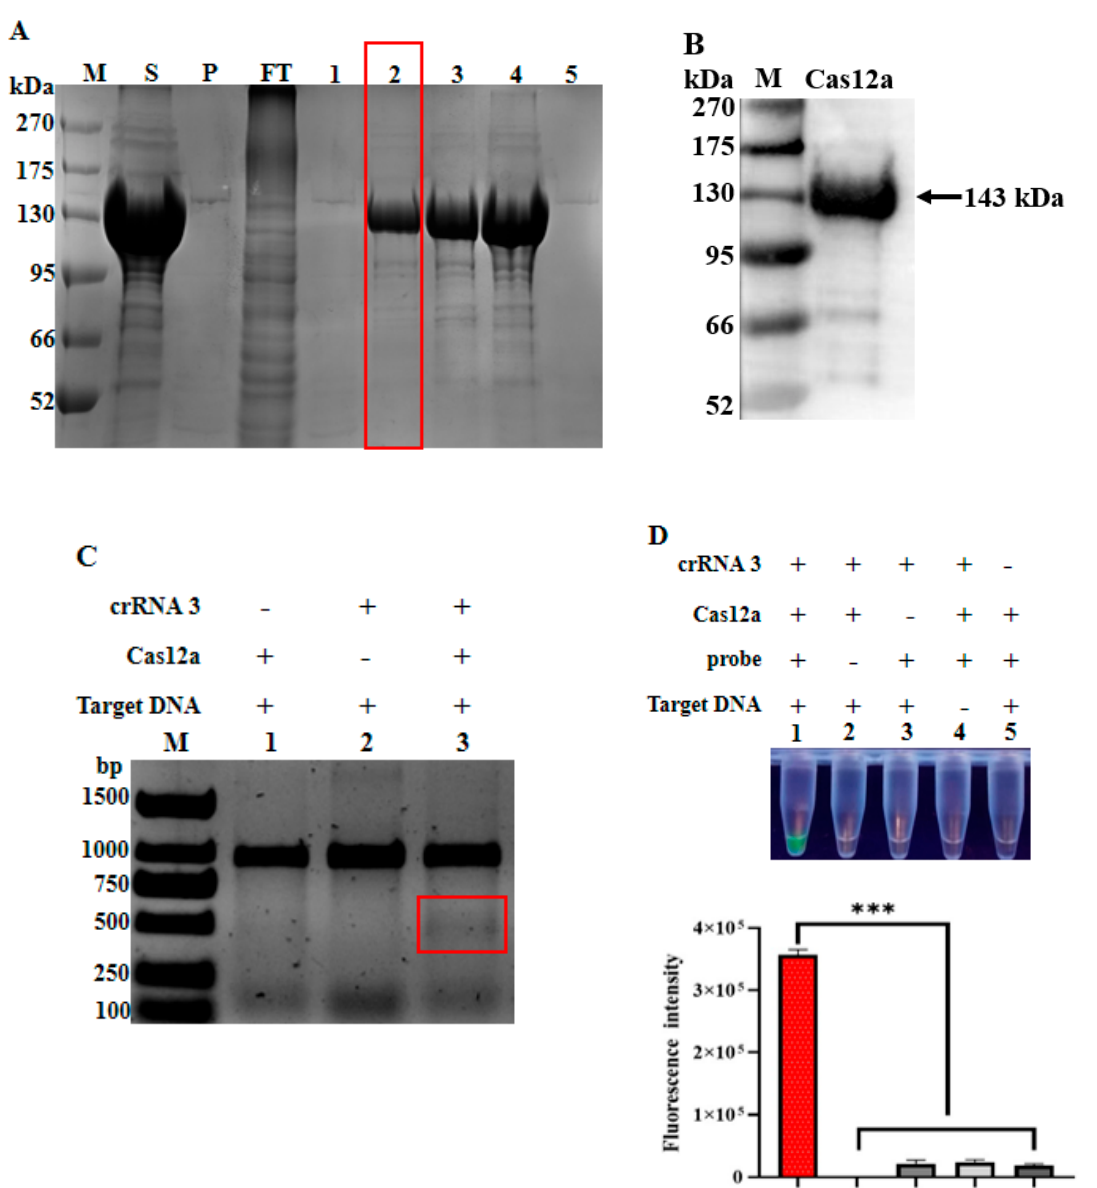
Figure 2. Purification huLbCas12a protein and its cleavage activity analysis. ( A ) The supernatant and precipitation of lysed Rosetta DE3 was fractioned by SDS-PAGE and stained by Coomassie blue. M: PM0500 protein Marker; P: Precipitation; S: Supernatant; FT, Flow-through sample. 1, 2, 3, 4, 5: The proteins eluted by buffers containing different concentrations of imidazole including 10, 30, 50, 100, and 500 mM, respectively. The red-marked frame indicated the LbCas12a protein used for subsequent experiments. ( B ) Western blot analysis of the purified huLbCas12a protein. ( C ) The verification of the cis-cleavage activity of the LbCas12a protein was assessed by its cleavage of target DNA fragment and presented by nucleic acid gel electrophoresis. The red frame marked area represents the cleavage products. M: DL3000 DNA Marker; the presence (+) or absence ( − ) of individual components is indicated above. ( D ) The trans-cleavage activity of LbCas12a protein. the presence (+) or absence ( − ) of individual components is indicated above the panel. Corresponding fluorescence intensity of each tube is shown in the lower panel ( n = 3 technical replicates, value represents mean ± SEM, where *** represents p < 0.001).